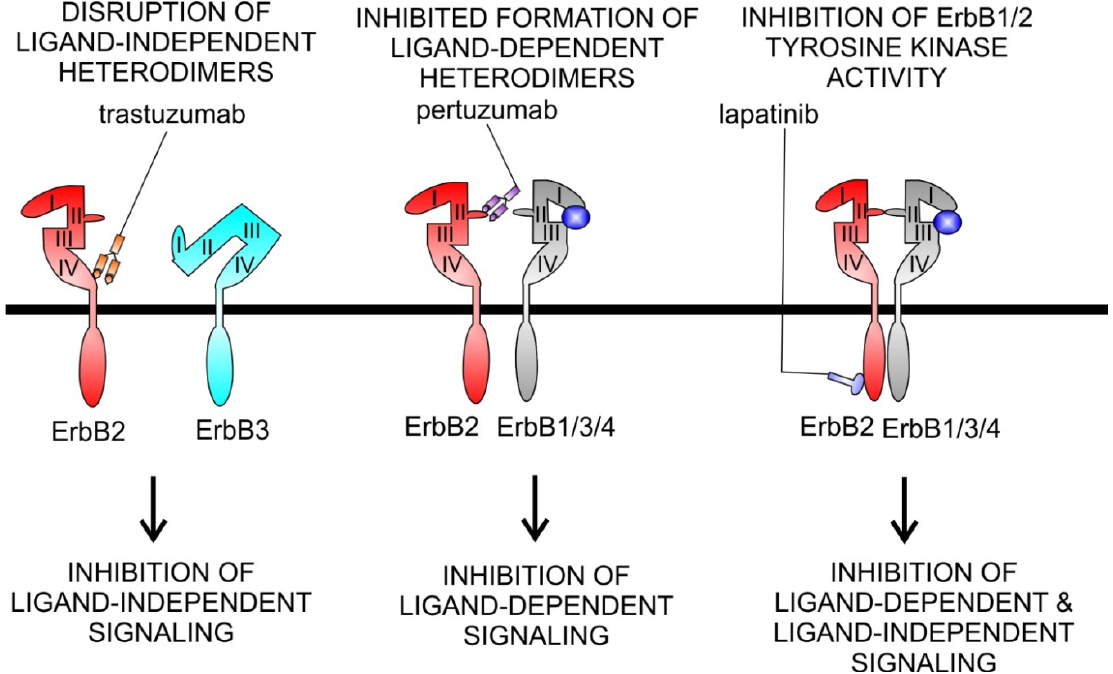
Figure 3. Mode action of current ErbB2 inhibitors. Trastuzumab, pertuzumab, and lapatinib have a different mode of action on ErbB signaling. Trastuzumab ( left ) is a humanized monoclonal antibody to subdomain IV of ErbB2. This leads to disruption of ErbB2-ErbB3 complexes, formed when ErbB2 is overexpressed, and in absence of ligand-binding to ErbB3. The mechanisms of this disruption are still unclear. Disruption of these complexes inhibits PI3K signaling and Akt activation and explains the antiproliferative effects of trastuzumab in ErbB2-amplified tumour cells. Effects of trastuzumab on ligand-induced dimerization of ErbB receptors seem minor or absent. Pertuzumab ( middle ) is a humanized monoclonal antibody to subdomain II, the dimerization arm of ErbB2. Pertuzumab leads to inhibition of ligand-induced ErbB2 signaling, not of ligand-independent ErbB2 signaling. Lapatinib ( right ) is a small molecule tyrosine kinase inhibitor of ErbB1 and ErbB2. Lapatinib blocks tyrosine kinase activity, independently of whether this activity has been triggered by a ligand or